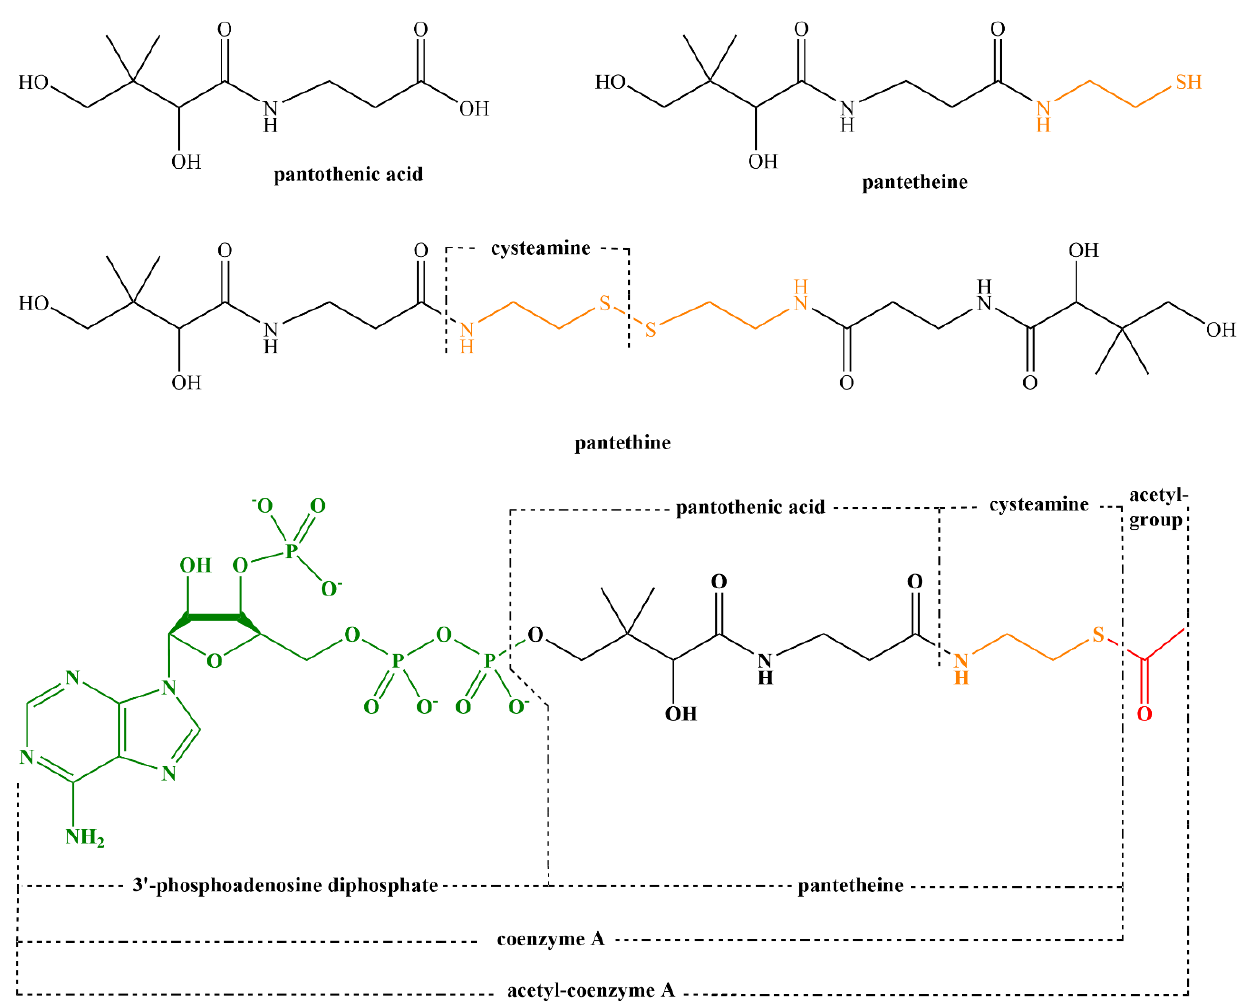
Figure 14. Structure of pantothenic acid, pantetheine, pantethine, and acetyl-CoA.